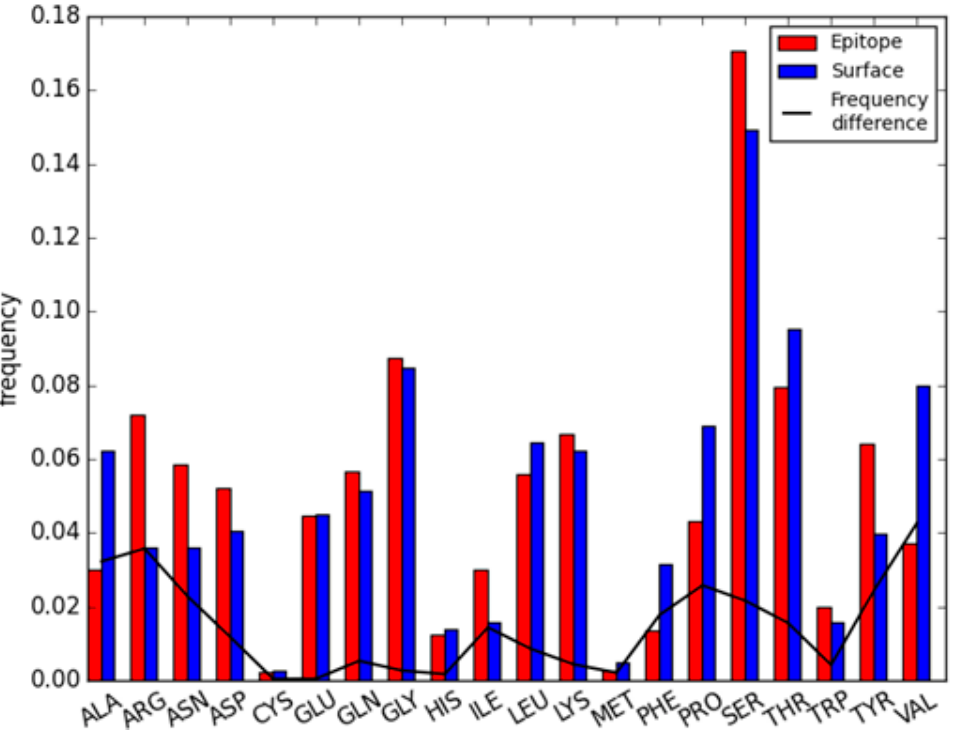
Figure 1. Amino acid distribution of both epitope region and surface non-immunogenic region on antibody.